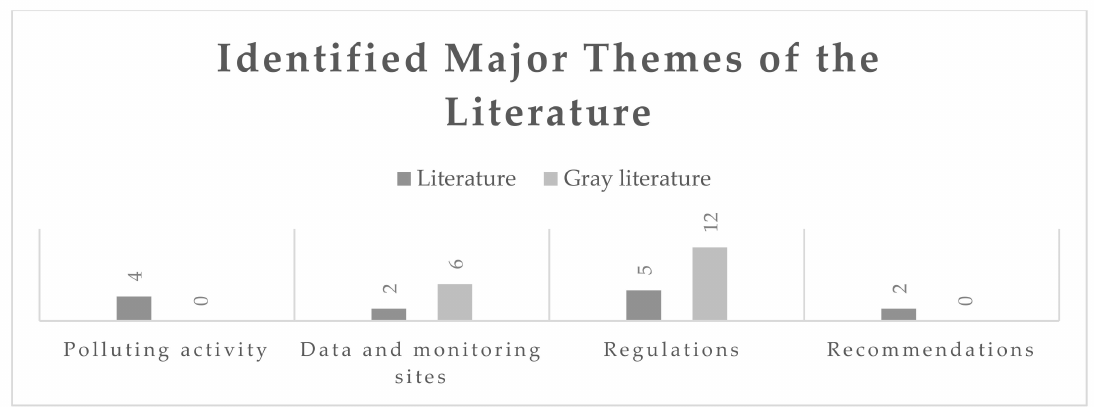
Figure 2. Main themes of the scoping review as found in the